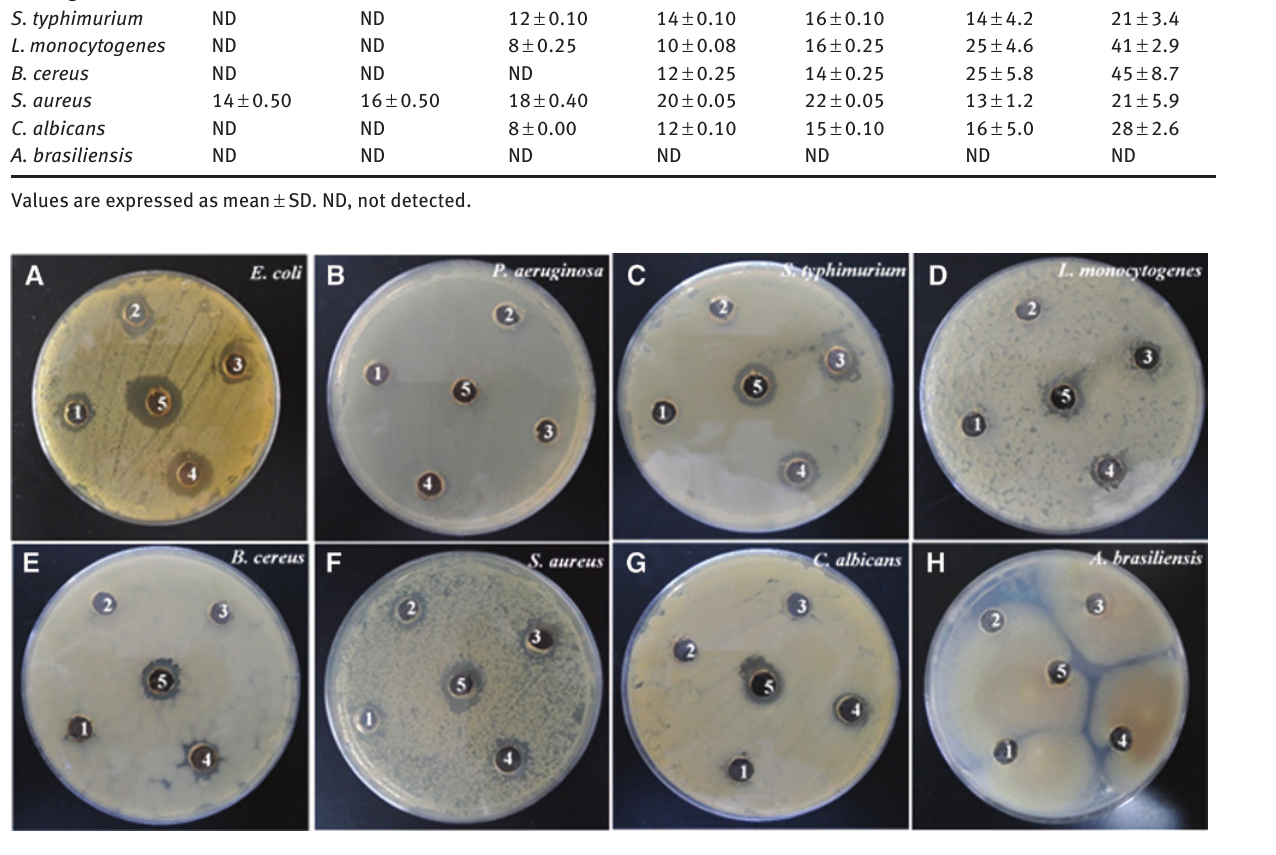
activity against Bacillus subtilis , B. cereus , E. coli , and C. albicans with inhibition zone diameters of 32, 28, 21, and 24 mm,